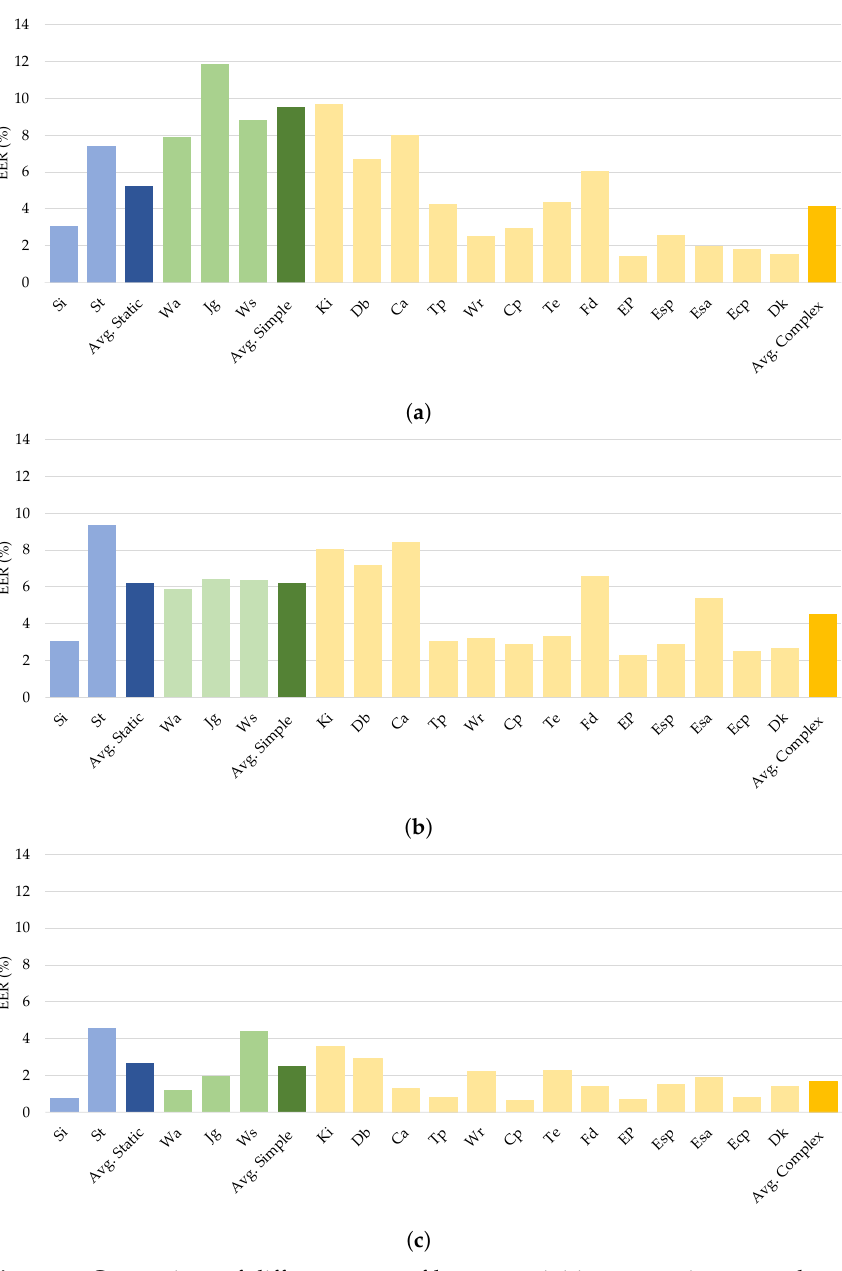
Figure 9. Comparison of different types of human activities on continuous authentication from ( a ) CNN, ( b ) LSTM, and ( c )